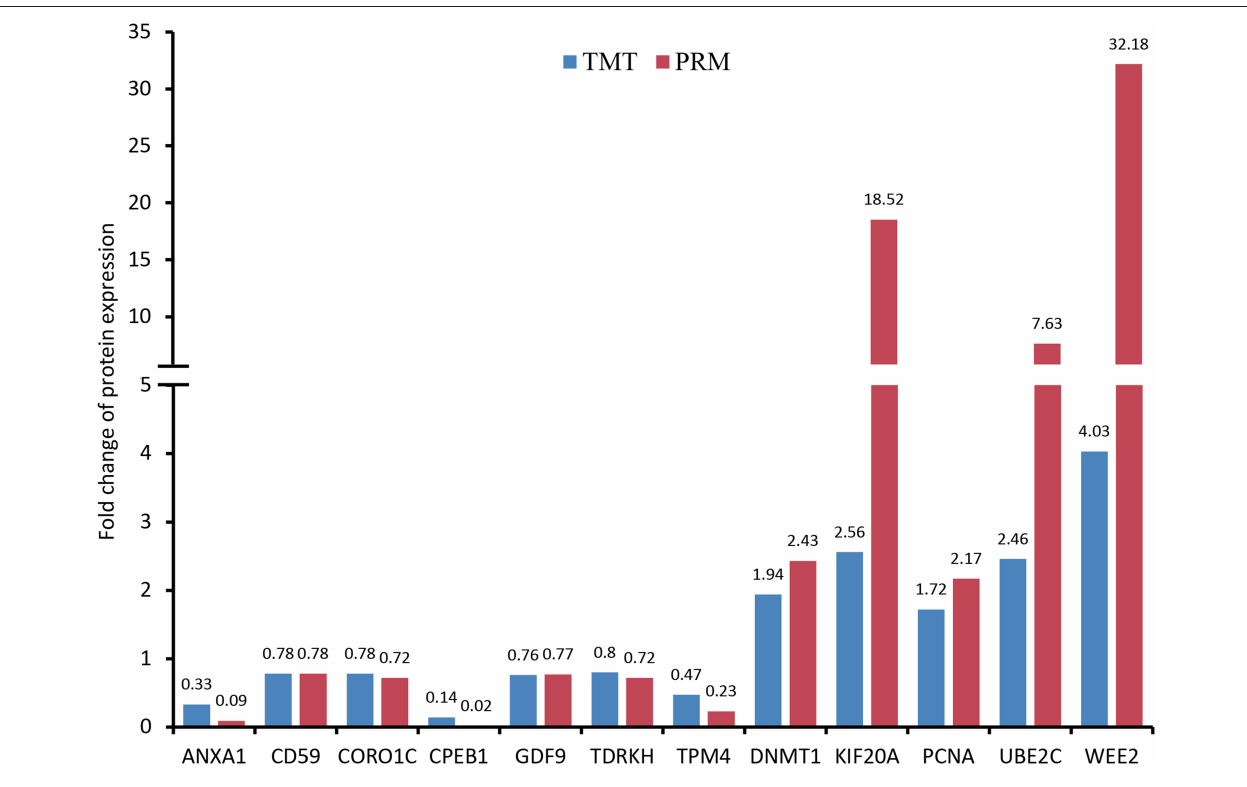
FIGURE 7 | Validation of differentially expressed proteins (DEPs) using parallel reaction monitoring (PRM) analysis. There are 12 candidate DEPs obtained to verify the tandem mass tag (TMT)